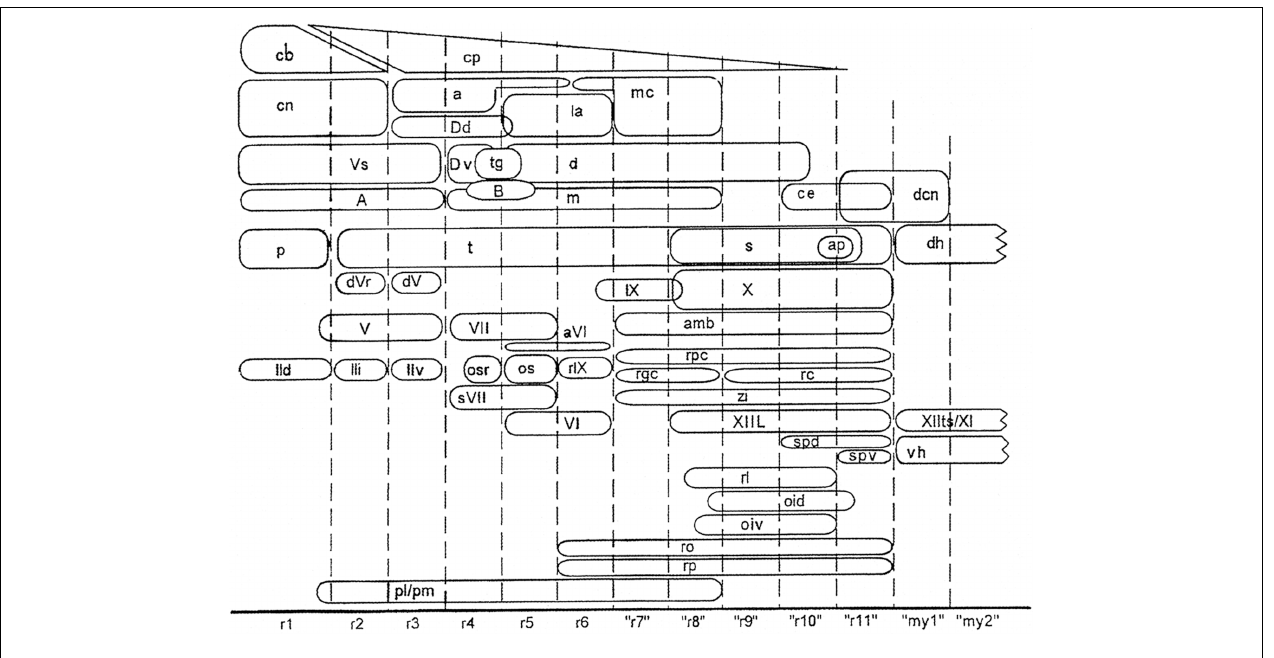
FIGURE 9 | Fate map of avian rhombomeric domains, summarizing data from Marín and Puelles (1995) for rhombomeres r1–r6, and from Cambronero and Puelles (2000) for cryptorhombomeres “r7”–“r11” and cryptomyelomeres “my1” and “my 2.” The diagram shows the